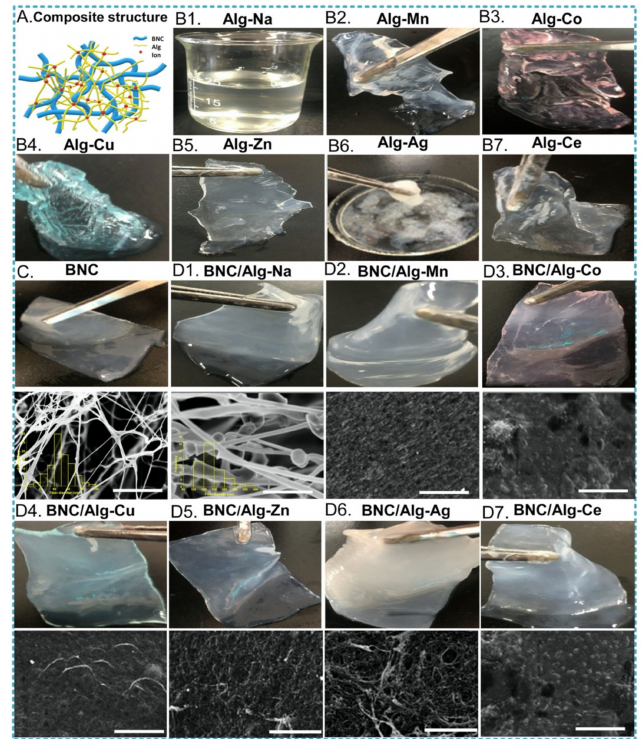
Figure 2. Schematic diagram of metal cation cross-linked Alg / BNC composite hydrogels with the double-network structure ( A ), visual image of Alg-Na aqueous solution ( B1 ) and cation cross-linked Alg hydrogels ( B2 – B7 ), visual and FE-SEM images of pristine BNC membrane ( C ), as well as visual and FE-SEM images of cross-sections of BNC / Alg-Na ( D1 ) and metal cation cross-linked Alg / BNC composite hydrogels ( D2 – D7 ). The scale bar is 2 µ m (amplification: ×